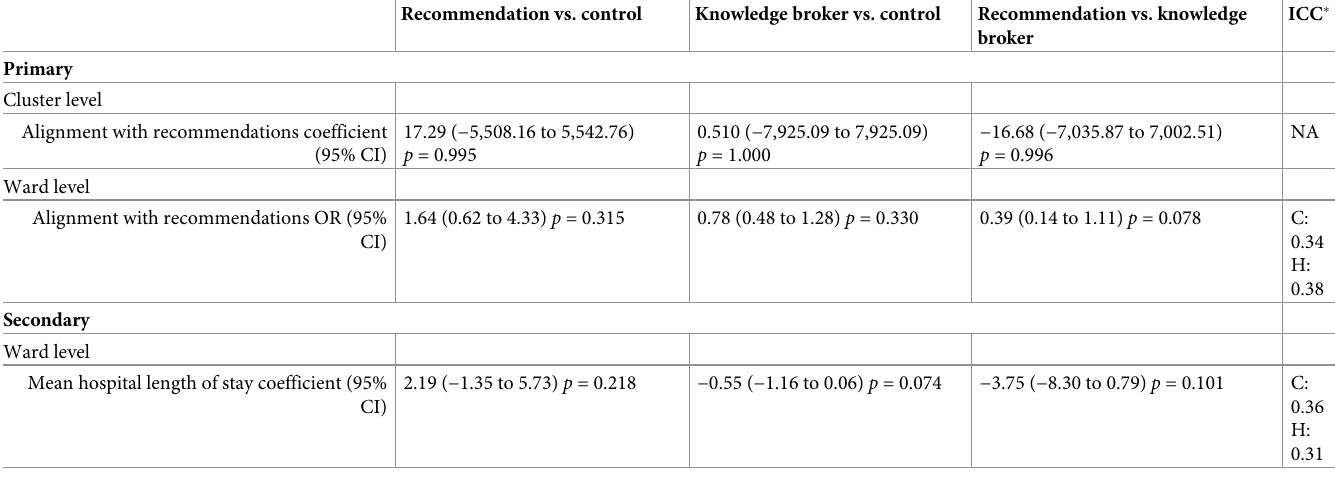
Table 7. Complete case effect size estimates for primary and secondary outcomes sensitivity